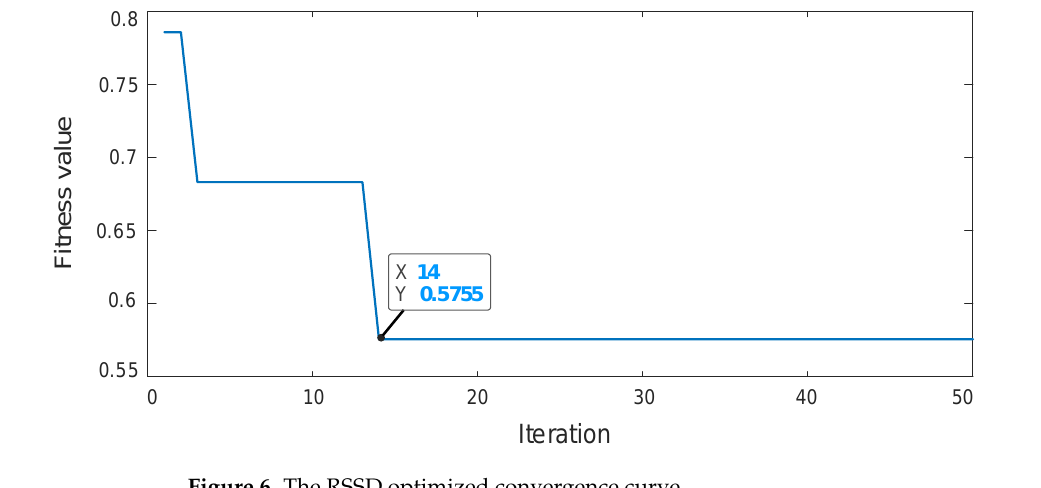
Figure 6. The RSSD optimized convergence curve.